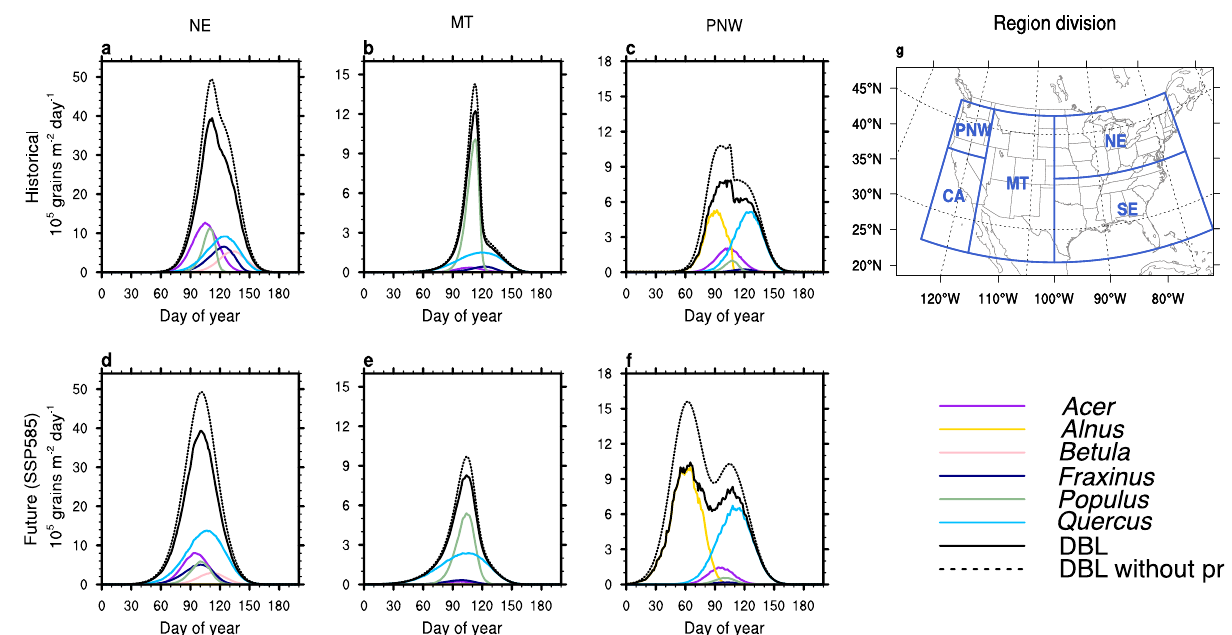
Fig. 3 Simulated regional pollen seasonal magnitude and timing in the historical and future. a – f Twenty-year average time series of daily pollen emission fl ux (grains m − 2 d − 1 ) of the six dominant individual tree taxa in the deciduous broadleaf forest (DBL) and the total DBL emission with (solid black line) and without (dashed black line) precipitation effects. a – c Historical (1995 – 2014) emission and ( d – f ) end of the century (2081 – 2100) emissions from multi- model average simulation for shared socioeconomic pathway (SSP) 585. g We de fi ne fi ve geographic regions: Northeast (NE; 38 – 48° N and 70 – 100° W), Southeast (SE; 25 – 38° N and 70 – 100° W), Mountain (MT; 25 – 48° N and 100 – 116° W), California (CA; 25 – 40° N and 116 – 125° W) and Paci fi c Northwest (PNW; 40 – 48° N and 116 – 125° W). Three regions are selected for DBL daily pollen emission analysis: Northeast, NE ( a , d ); Mountain, MT ( b , e ); Paci fi c Northwest, PNW ( c , f